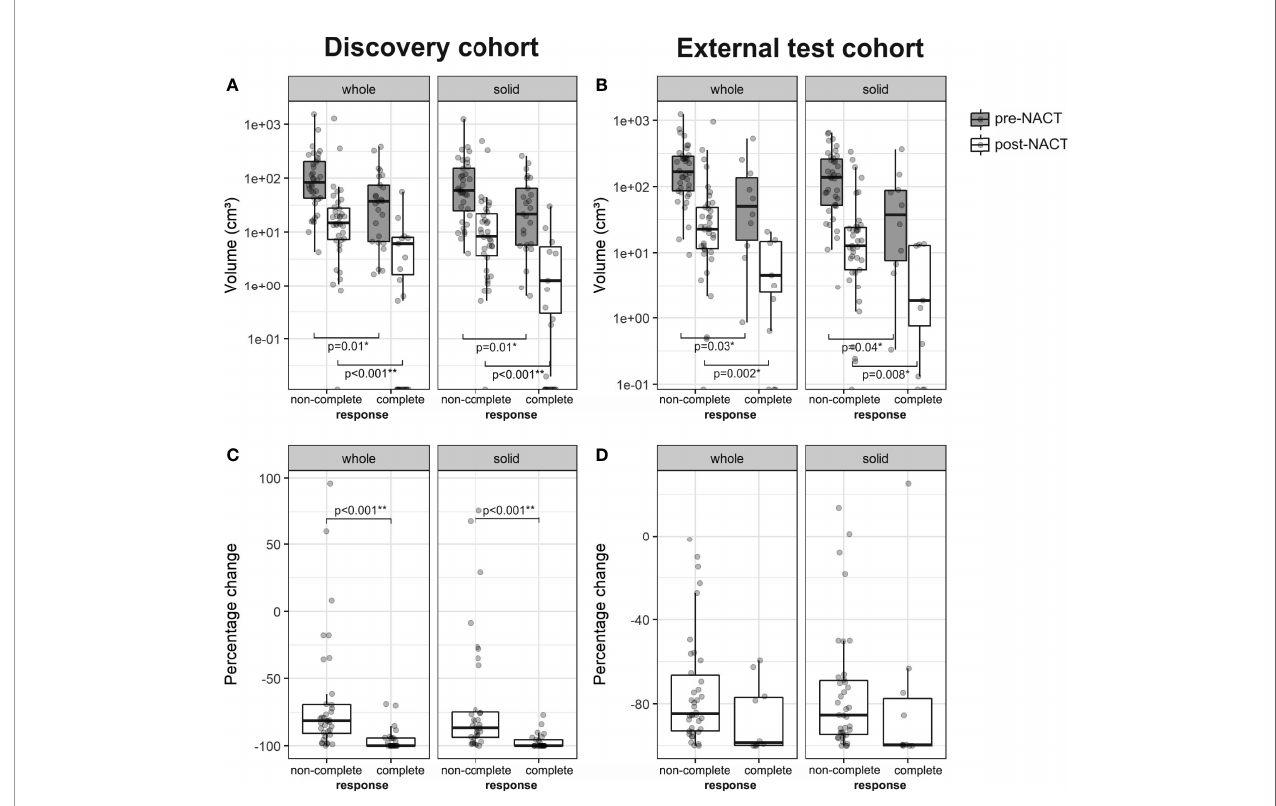
FIGURE 3 | Boxplots of the whole tumor and solid tumor volume in patients with non-complete (CRS1-2) and complete response (CRS3) from the (A) discovery ( n = 61, non-complete response = 36, complete response = 25) and (B) external test cohorts ( n = 48, non-complete response = 38, complete response = 10). Percentage change of whole tumor and solid tumor volume is shown in (C) for the discovery cohort and in (D) for the external test cohort. For pre- and post-NACT volumes, a logarithmic scale was used on the y